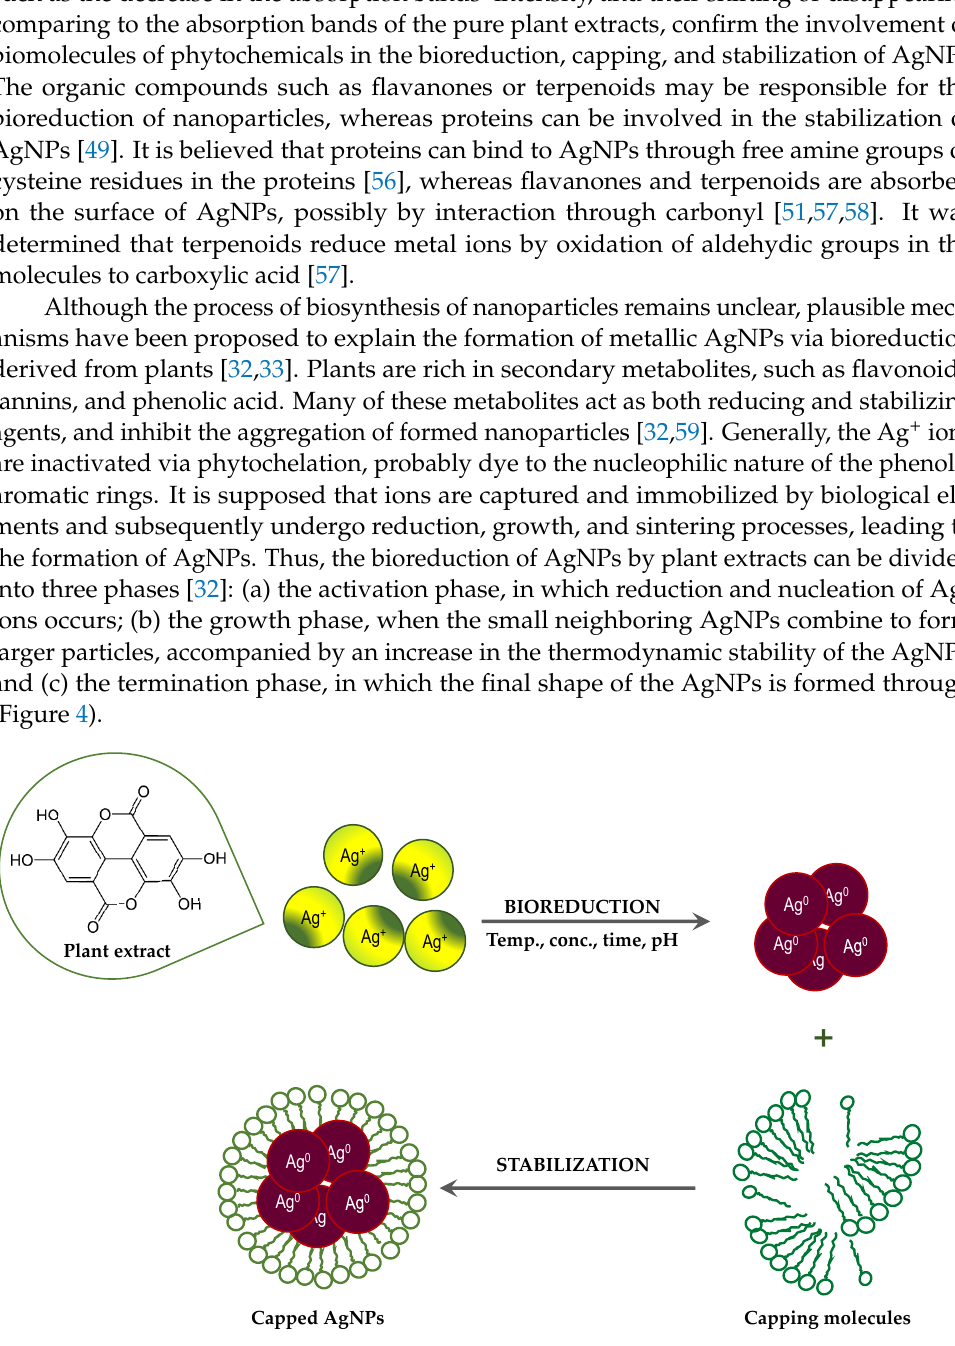
Figure 4. Suggested mechanisms for the formation of AgNPs via bioreduction derived from plant extracts.